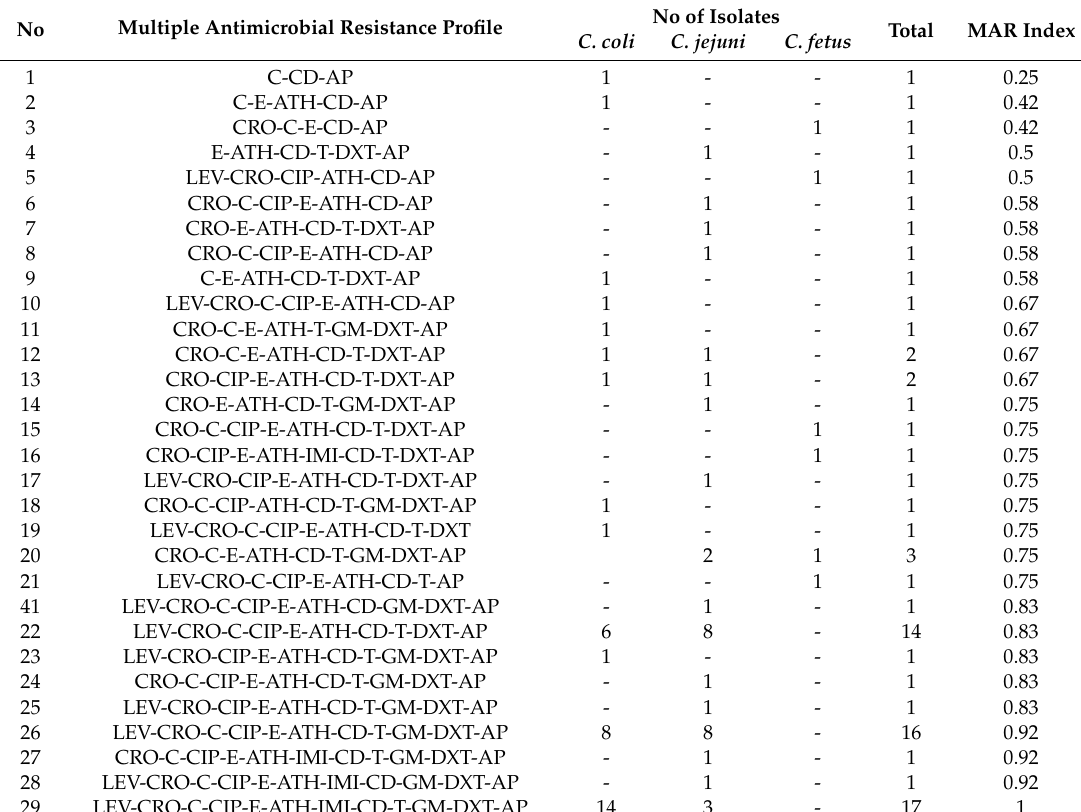
Table 5. Antibiotic resistance patterns of Campylobacter isolates isolated from meat carcasses.